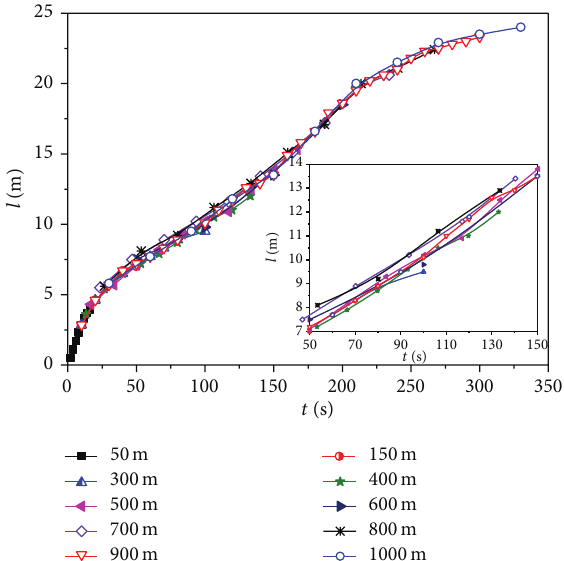
Figure 5: The gas mixture length varied with time in pipes of different lengths.